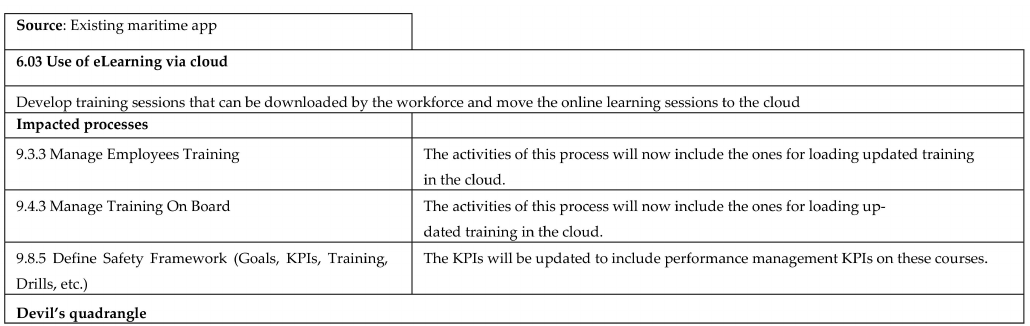
Figure A41. Cont